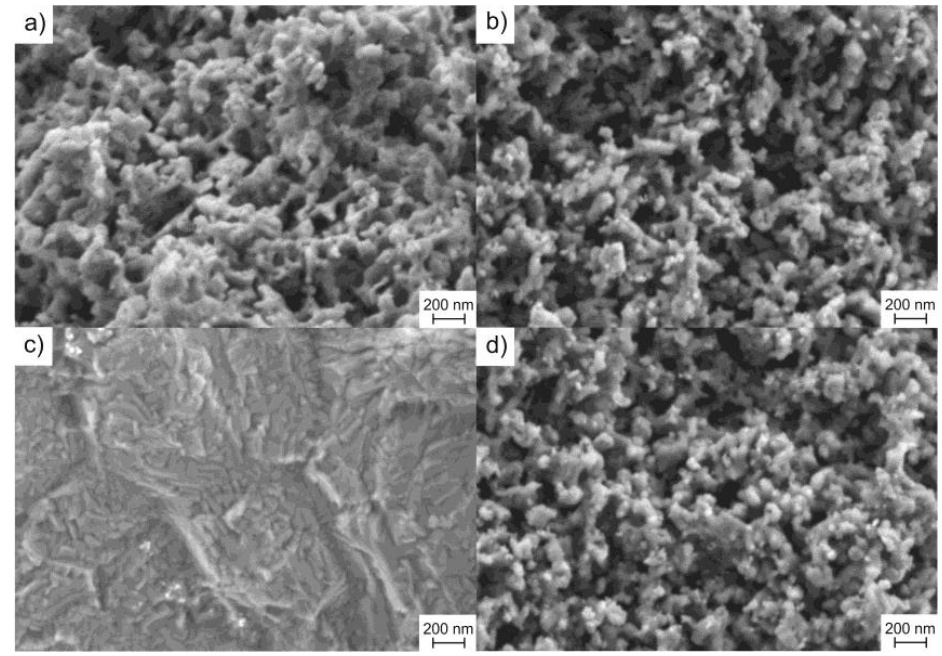
Figure 2. SEM images of the virgin sorbents and the same sorbents after the 50 cycle: ( a , c ) the pure CaO sorbent; ( b , d ) the Zr-doped CaO sorbent.